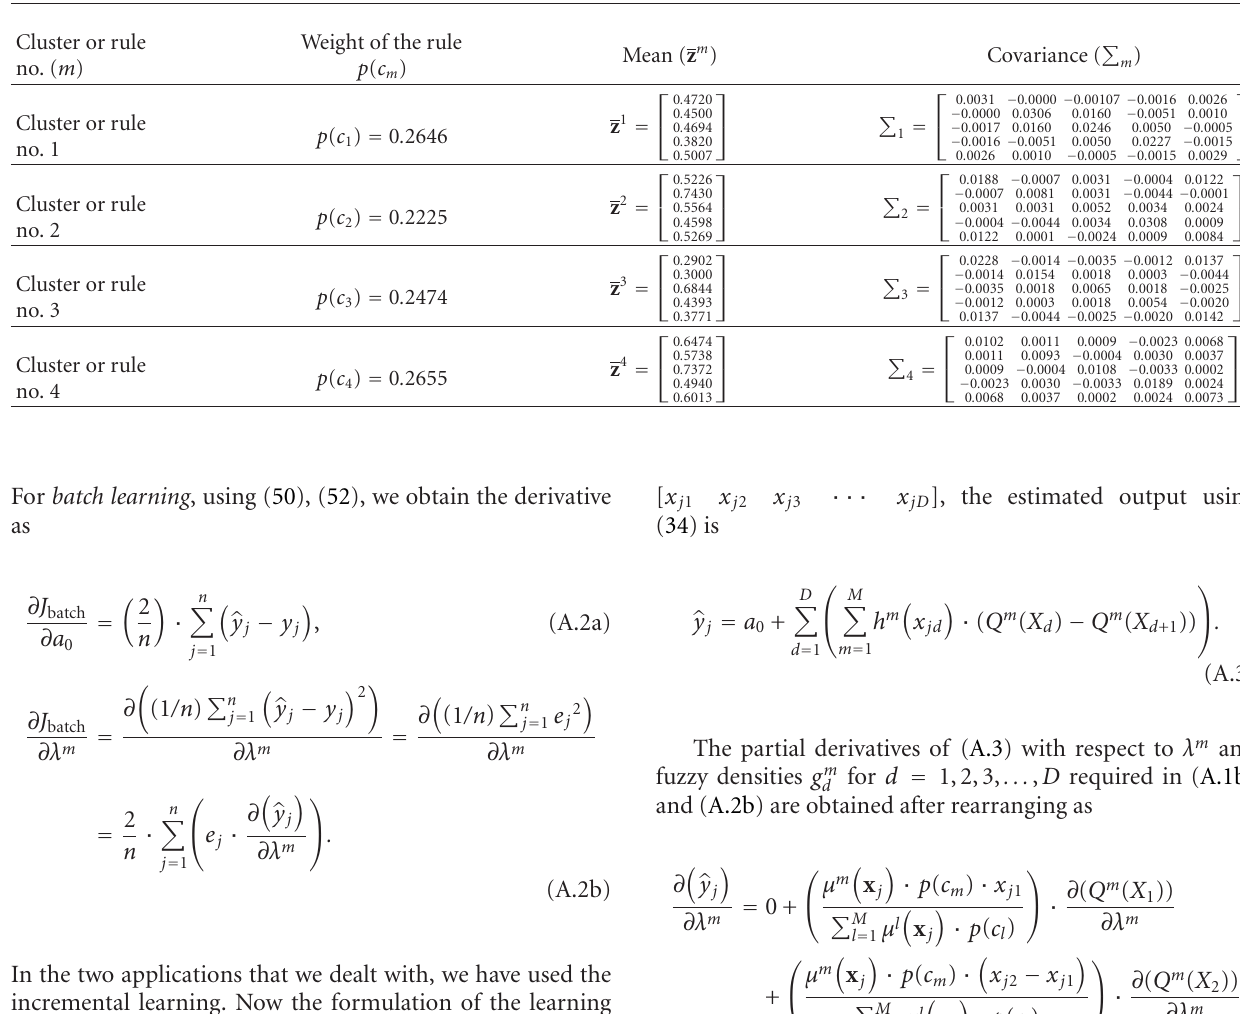
Table 13: Estimated parameters of A 4-component GMM using the EM algorithm